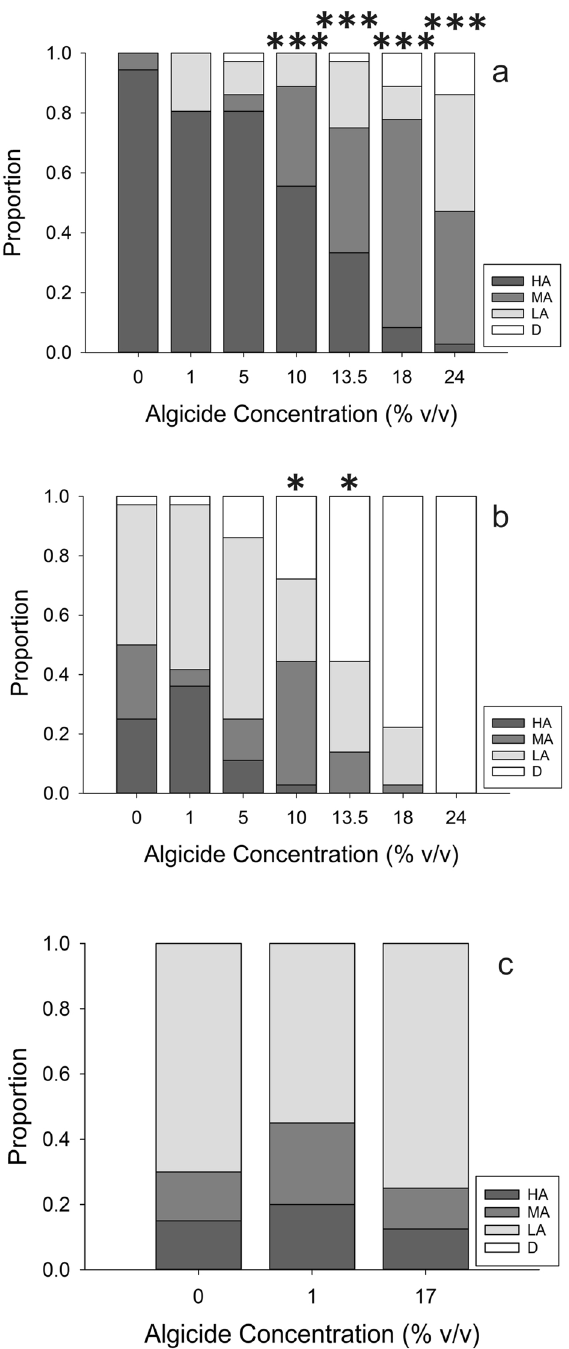
Figure 7. Activity of C. virginica larvae during the mortality experiments. Activity was scored at the beginning of the experiment (where all animals were scored High Activity), then at 24 ( a ) and 48 ( b ) hours. The 18% and 24% concentrations were unable to be tested at 48-h due to high mortality. Concentrations 10% and higher lead to changes in activity. Activity from the end of the LAM experiments is given in plot ( c ). There were no differences in activity at the end of the LAMs. (* p < 0.05; *** p <